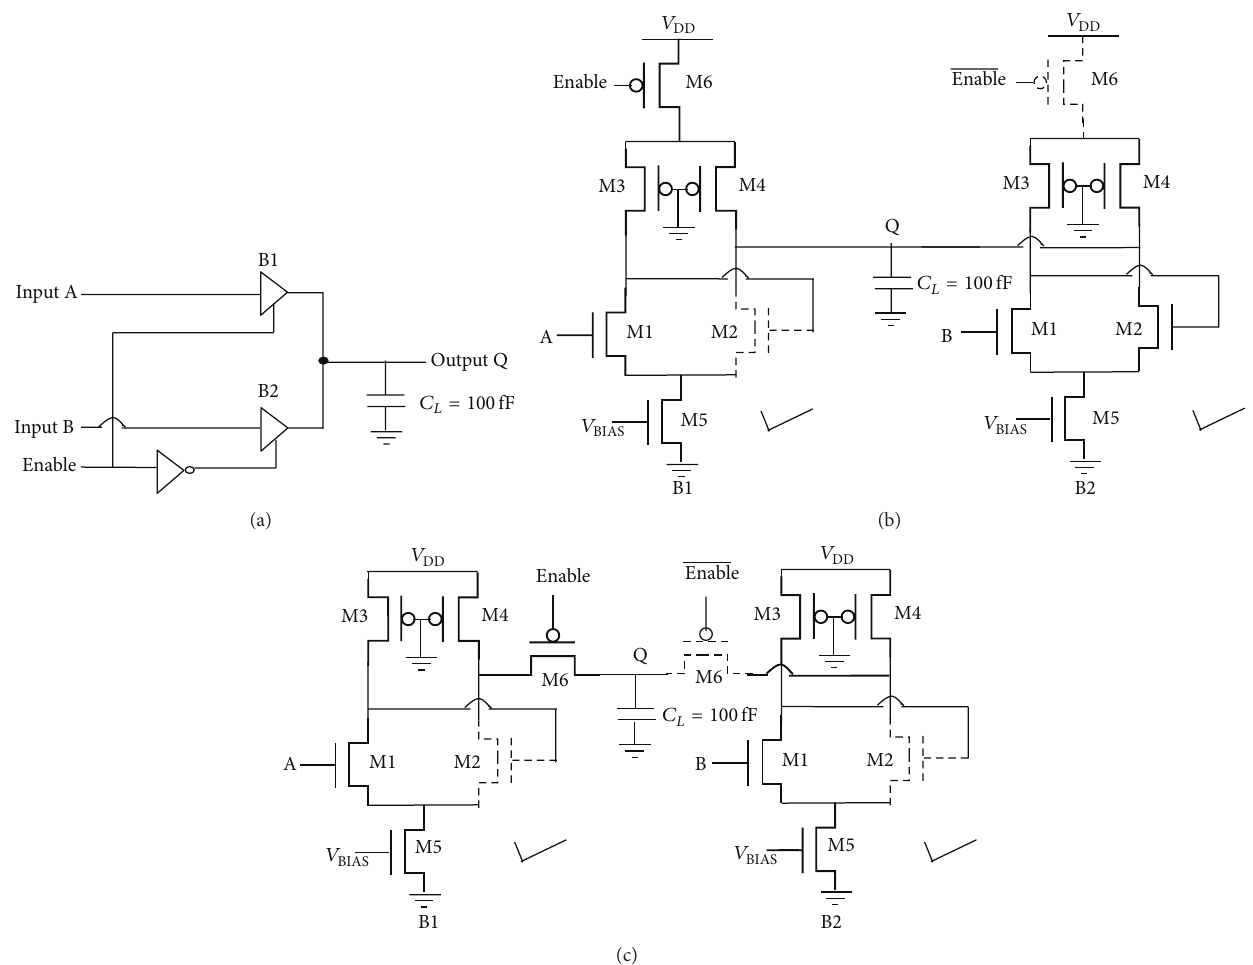
Figure 2: (a) Simulation test bench. (b) Bus operation by using sleep based tristate buffers. (c) Bus operation by using switch based tristate